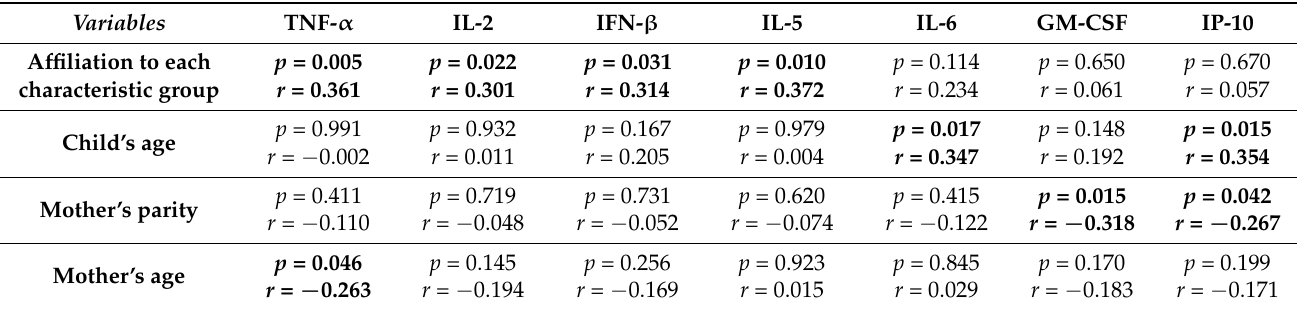
Table 4. p and r correlation coefficients related to the statistically significant correlations recorded in the entire group of